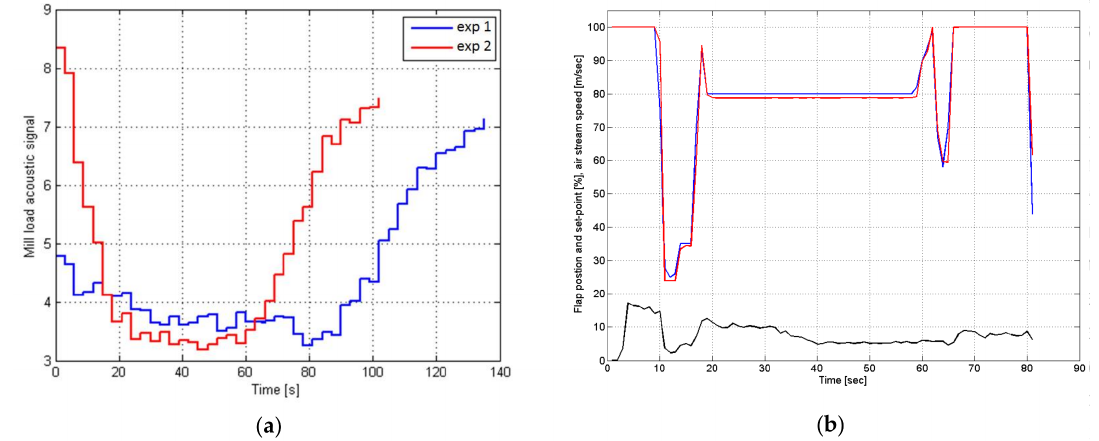
Figure 14. Example of response of the direct layer control system presented in Figure 13.